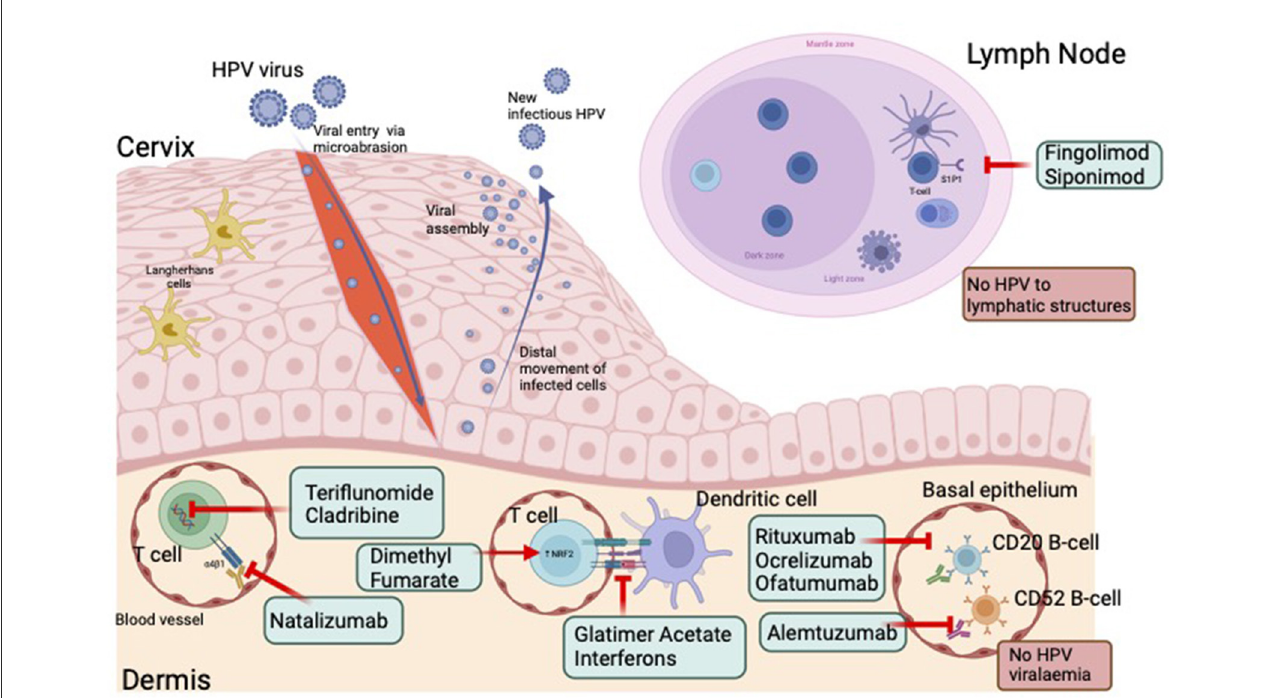
FIGURE2 HPV infection, immune response and effect of disease modifying therapies. HPV enters the basal keratinocytes of the cervical epithelium through micro-abrasions. As keratinocytes migrate to the upper epidermis there is increasing viral replication. New infectious HPV is released from the surface of the epithelium. The absence of HPV viraemia or lymphatic infection, results in minimal exposure of HPV to the circulating immune system. DMTs alter the immune response via several mechanisms which may further limit immune surveillance and clearance of the virus. HPV, human papillomavirus. Created with